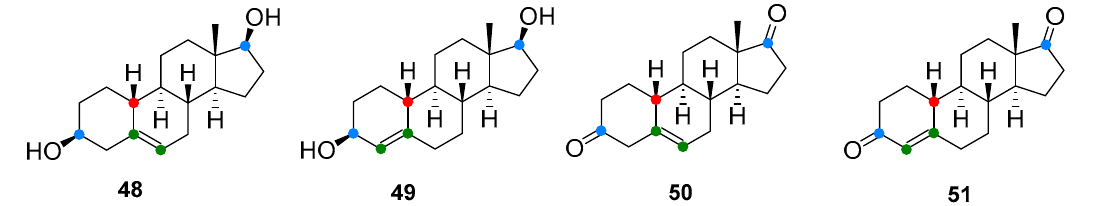
Figure 9. Testosterone prodrugs (prohormones).